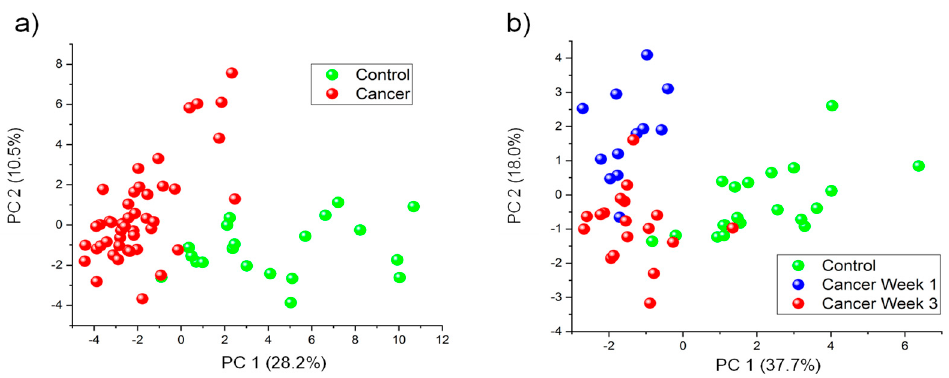
Figure 3. ( a ) PCA using all VOCs with p < 0.05 between all Cancer samples and Control samples (44 VOCs). This panel can distinguish Cancer Weeks 1 − 3 from Control with high accuracy. ( b ) PCA using 10 VOCs separating Cancer Week 1, Cancer Week 3 and Control samples. This smaller panel of VOCs can separate these classes with good accuracy.